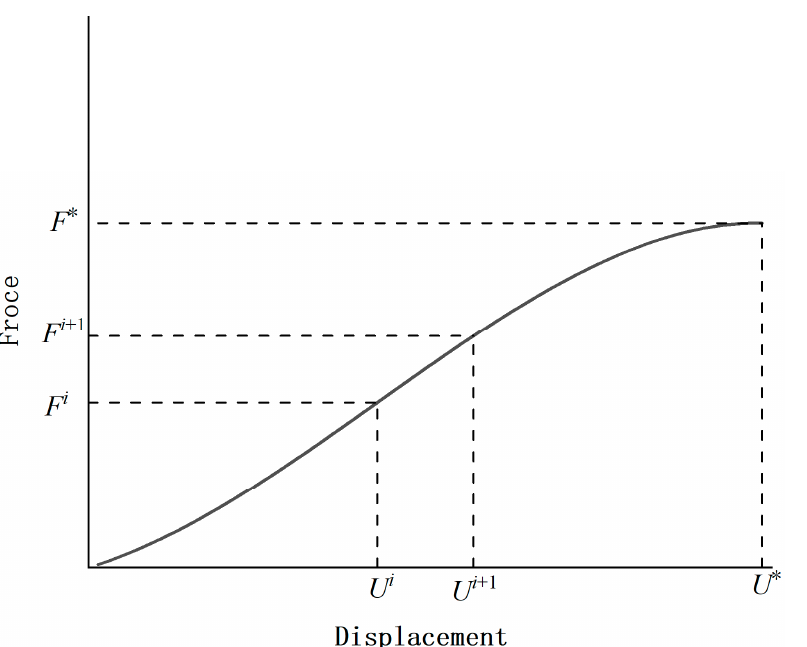
Figure 3. Radial-force-displacement of tire.